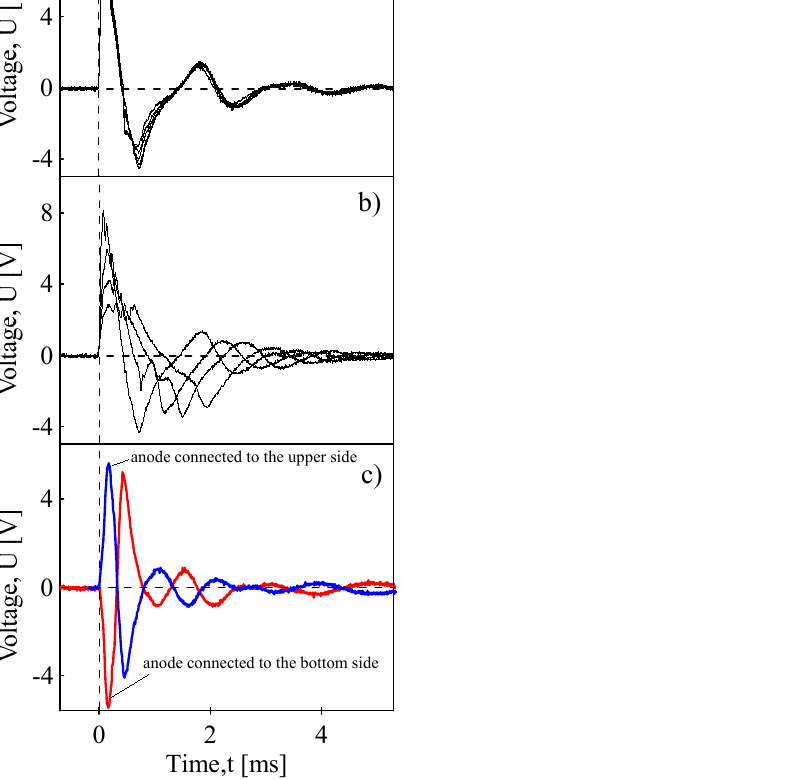
Figure 3. Piezoelectric response to a pressure pulse on the surface of PVDF membrane after pendu- lum impact. ( a ) Five impacts of the same mechanical energy, ( b ) response to impacts of pendulum when impacts were reduced by the absorbed impact energy from the previous cycle, ( c ) piezoelectric response when anode is connected to upper side or bottom side of membrane, respectively, demon- strating the polarity of the membrane.